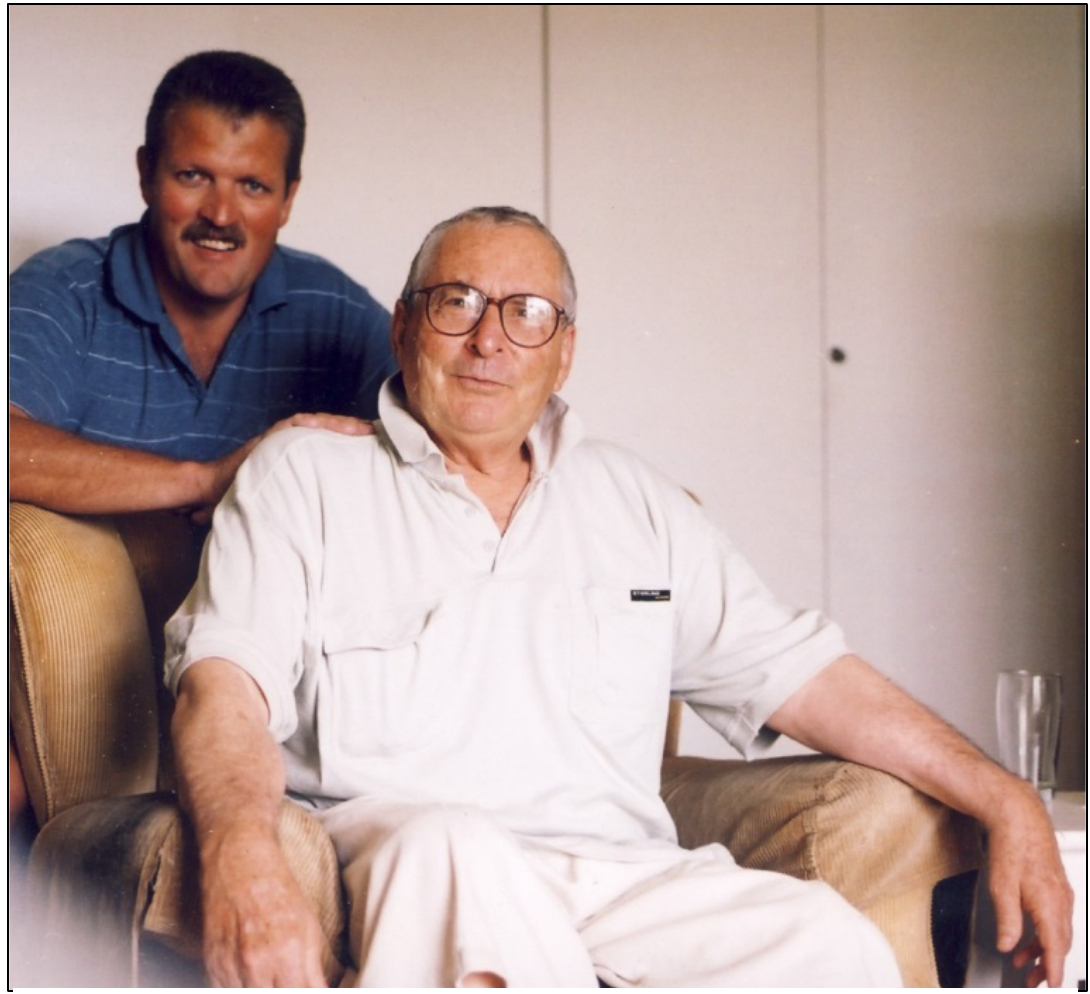
Figuur 5: Die navorser en Aucamp aan die einde van 2005 in sy